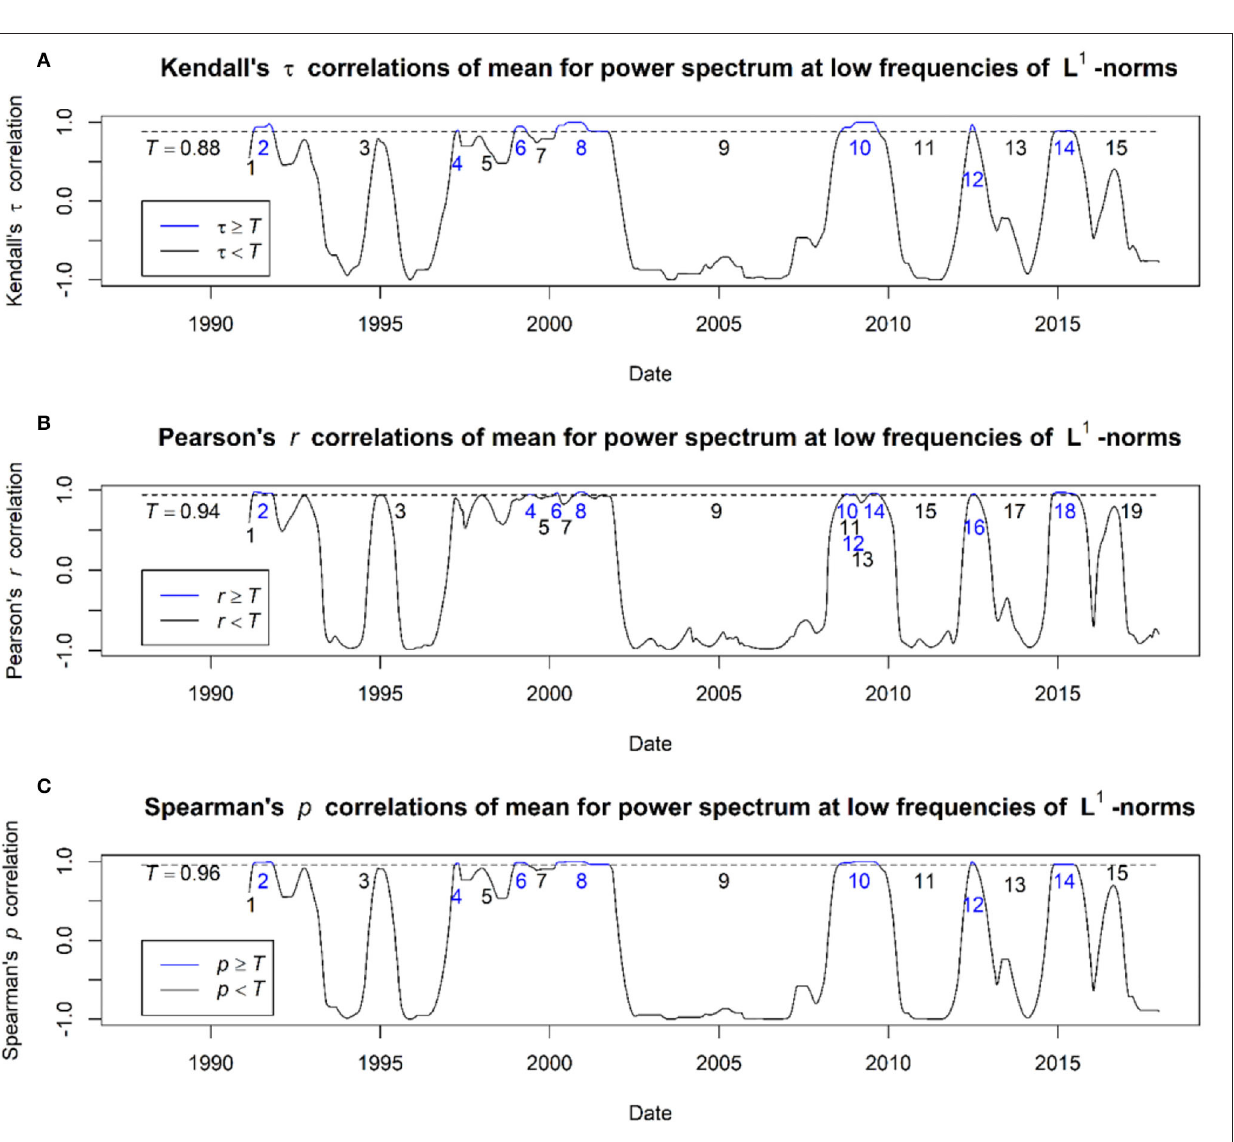
FIGURE 7 | Results obtained from MPS of the L 1 -norm time series using Kendall’s tau, Pearson’s, and Spearman’s rho correlations. (A) Kendall’s tau correlations of mean for power spectrum at low frequencies of L 1 -norms; (B) Pearson’s rho correlations of mean for power spectrum at low frequencies of L 1 -norms; (C) Spearman’s rho correlations of mean for power spectrum at low frequencies of L 1